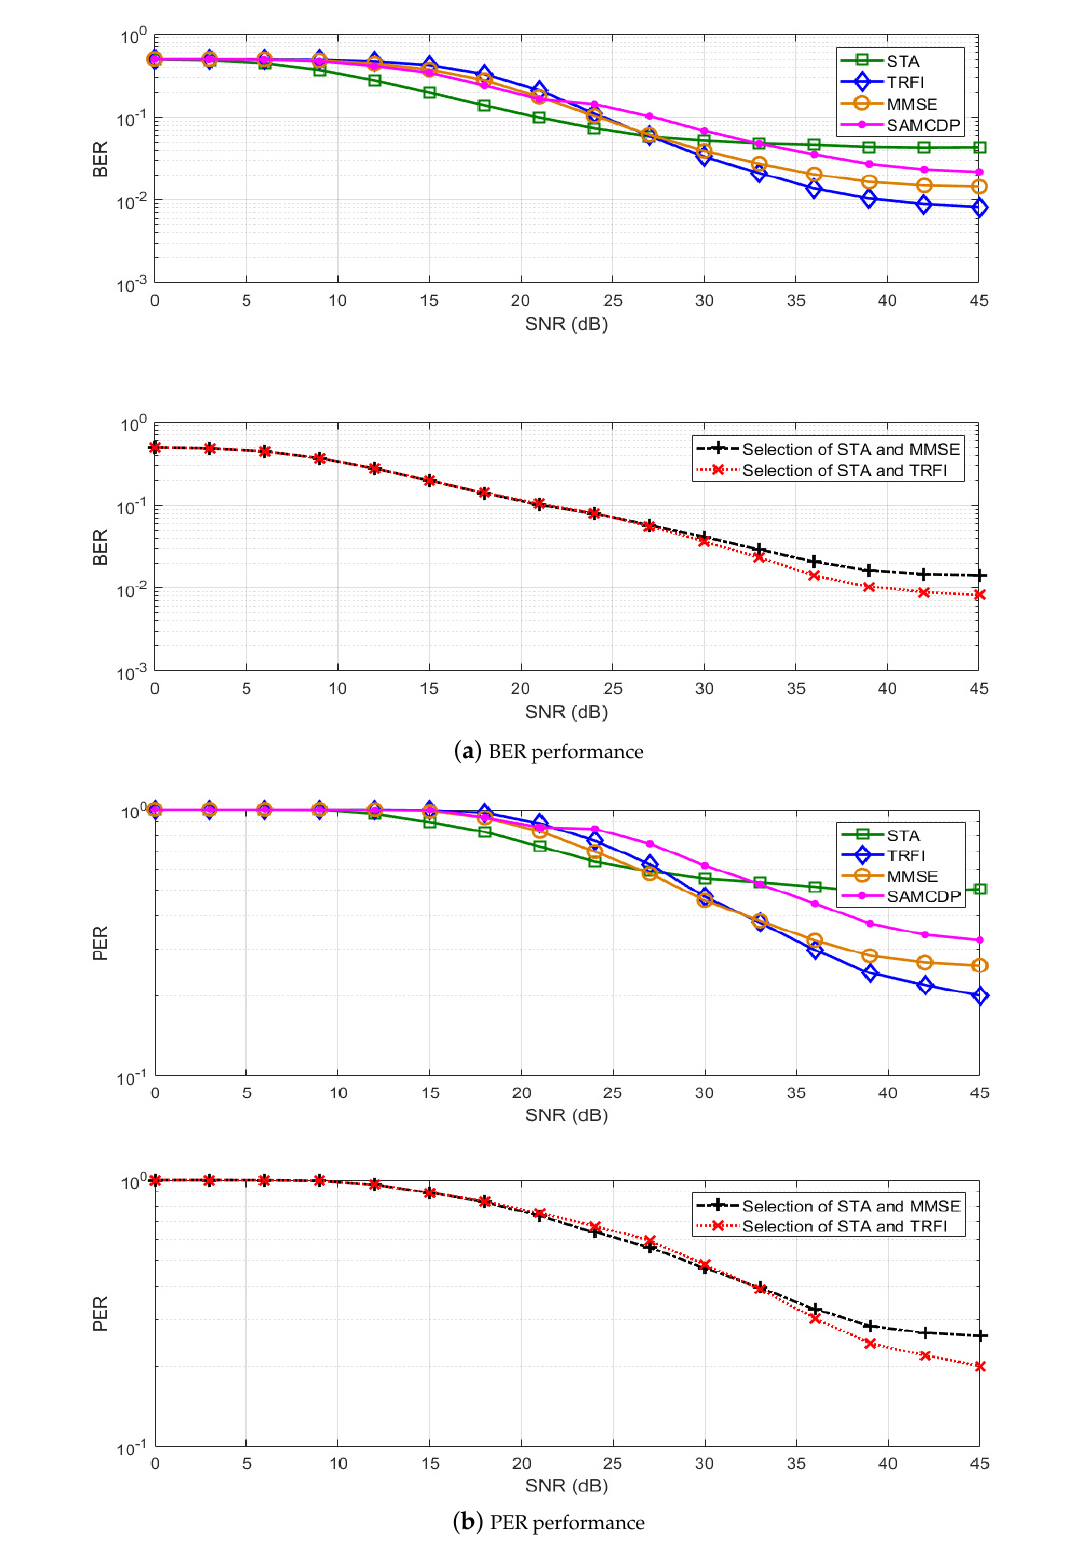
Figure 9. Performance analysis of STA, TRFI, MMSE, SAMMCDP, and the proposed scheme (V2I Urban Canyon, 16QAM 1/2, 50